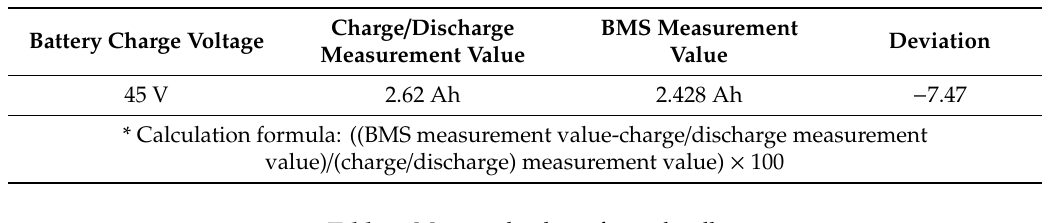
Table 8. Measured voltage for each cell.